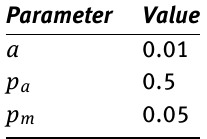
Table 2: Simulation parameters for CSA and